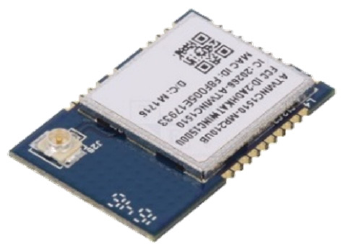
Figure 7. Wi-Fi module WINC1510. Table 7. Wi-Fi WINC1510 specification. Adapted from Ref. [31].